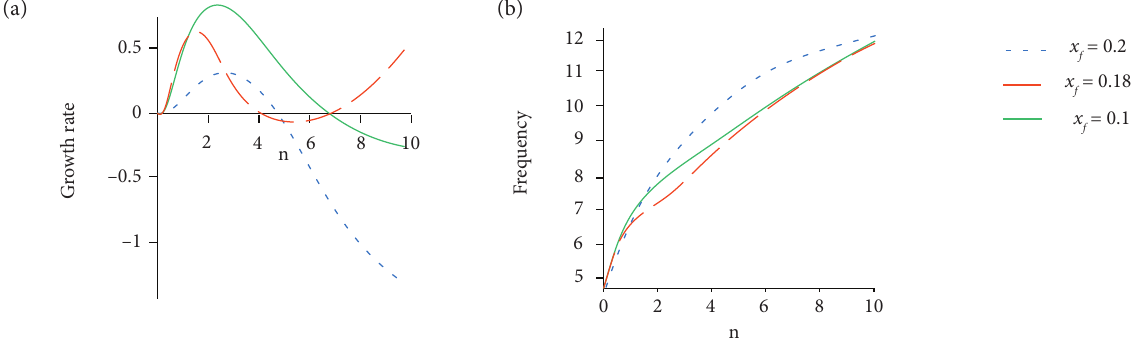
Figure 7. Thermoacoustic characteristics in a duct as flame position varies (1L mode, τ = 0.6) showing (a) growth rate and (b) frequency.